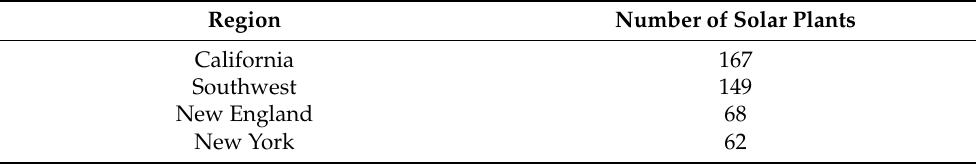
Table 2. Number of hypothetical utility level solar plants per region included in the study [48]. Region Number of Solar Plants